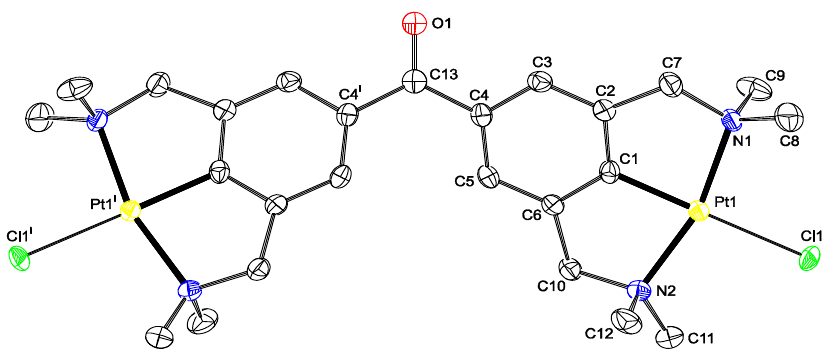
Figure 1. Displacement ellipsoid plot of 13 , drawn at the 50% probability level. Hydrogen atoms and disordered solvent molecules are omitted for clarity. The halogen position is occupied by 60% chlorine and 40% bromine; only chlorine derivative is shown. Symmetry operation i: −x, y, 0.5-z. Similar halogen scrambling was observed in both the 1 H- and 195 Pt{ 1 H}-NMR spectra, by the presence of two signals for the dimethylamino protons of the CH 2 NMe 2 groups, and likewise, in the 195 Pt-NMR spectrum two signals were found at − 3107 and − 3130 ppm resulting from the two different platinum halide species. From the mass spectrum, it became clear that for 13 only the X = Br, Cl, and X = Cl species were present, whereas no mass peak for the X = Br only was found (see Figure S1). To avoid halogen scrambling, it was decided to use only PtCl complexes in the rest of our